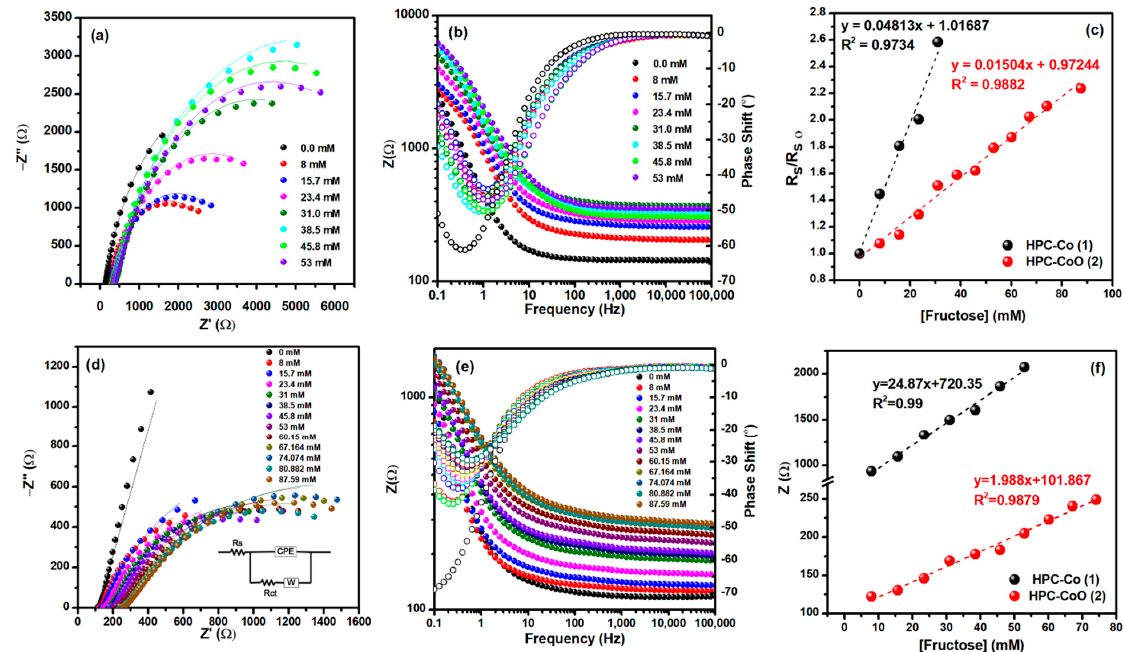
Figure 12. ( a , b ) Nyquist and Bode plots of HPC-Co (1) electrode, ( c ) calibration curve obtained from the normalized Rs in the presence of different concentrations of fructose in 0.1 M NaOH, ( d , e ) Nyquist and Bode plots of the HPC-CoO (2) electrode, ( f ) calibration curve obtained from the complex impedance at a frequency of 1 Hz for HPC-Co (1) and 100 kHz for HPC-CoO (2) in the presence of different concentrations of fructose in 0.1 M NaOH. The best-fitted equivalent circuit is shown as inset in ( d ). Table 1. Comparison between HPC-Co and HPC-CoO sensors with the previous reported methods in the literature. Detection Material